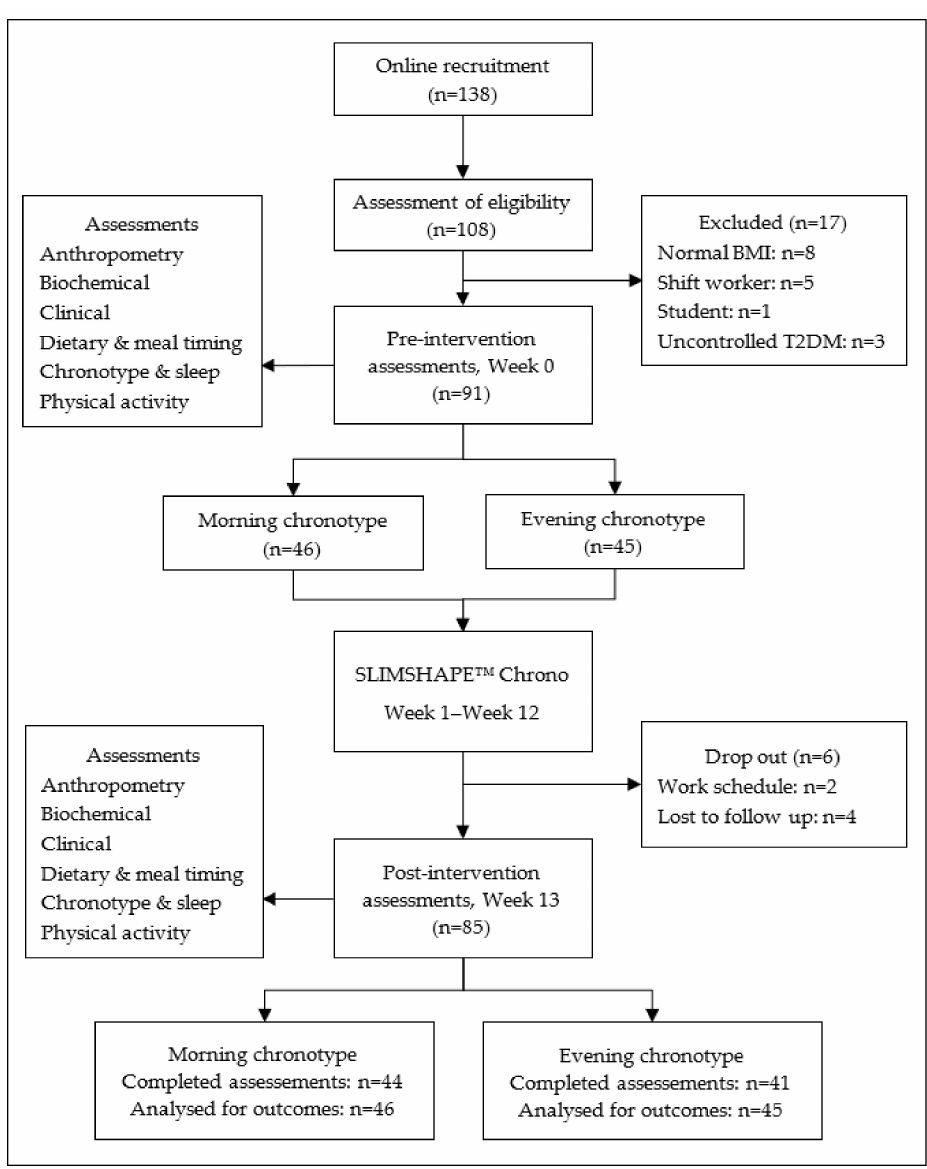
Figure 1. Flowchart of the SLIMSHAPE™